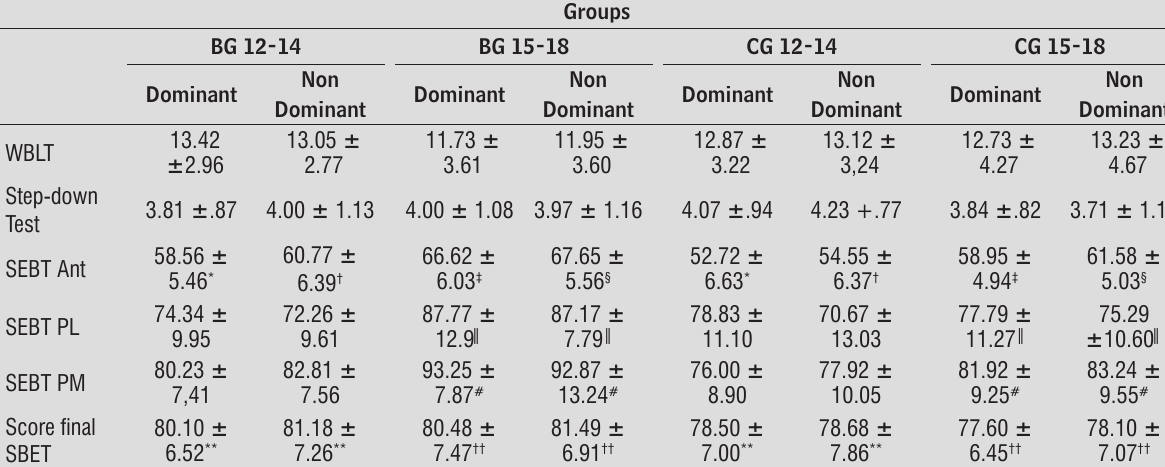
Table 2 - Comparation between groups